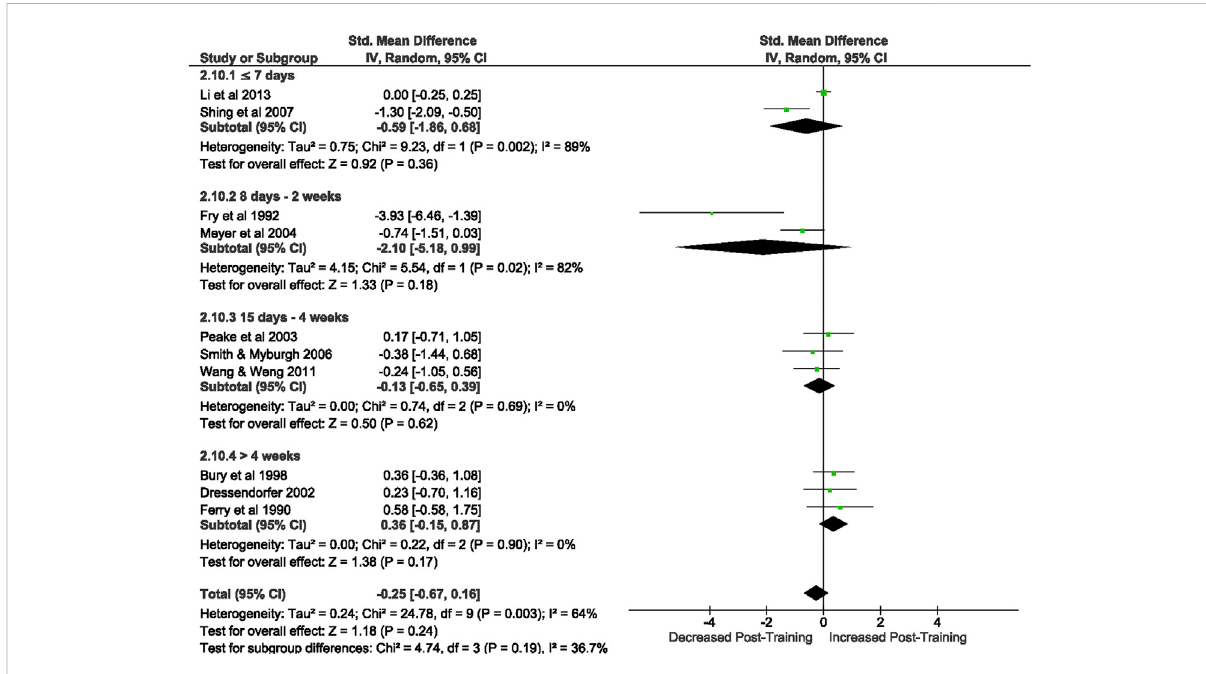
FIGURE 6 Effect of intensi fi ed training on resting CD4/CD8 ratio. Subgroup analysis is based on the duration of intensi fi ed training period; ≤ 7 days, 8 days — 2 weeks,15 days — 4 weeksand > 4 weeks.Studiesusedamixtureofhumanandrodent(Blanketal.,1994;Kaufmanetal.,1994)participants. CI Con fi dence